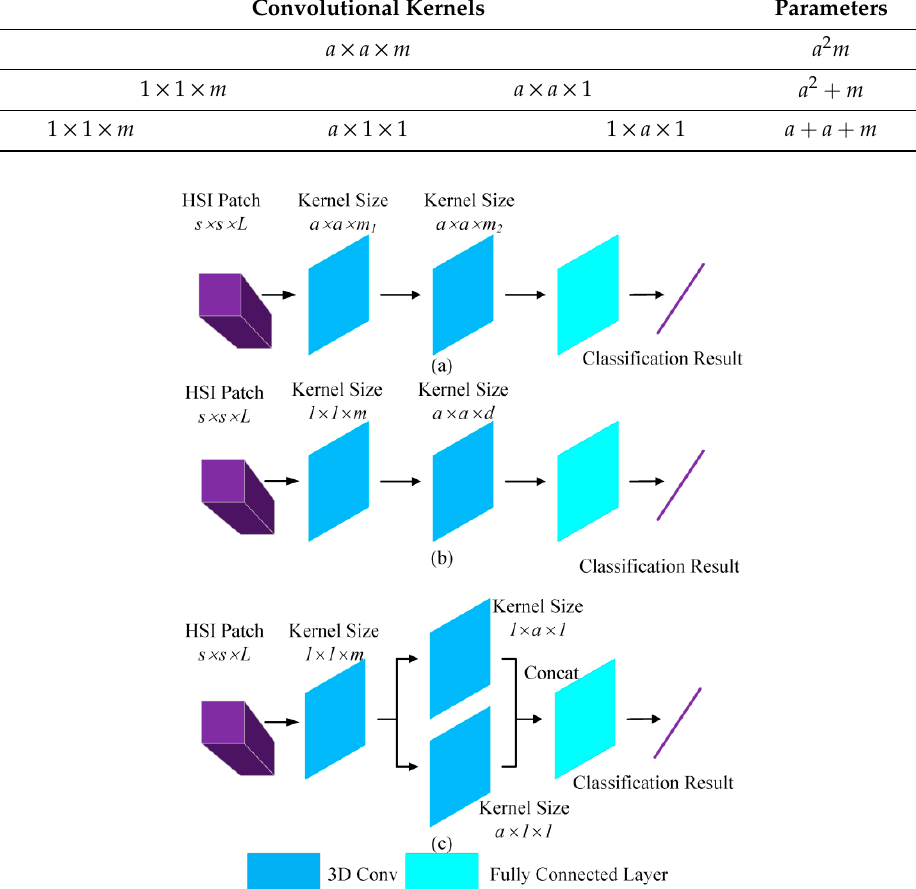
Figure 2. The structure of convolutional kernels in the 3D CNN-based method without a specific architecture. ( a ) 3D-CNN; ( b ) SSRN; ( c ) The proposed method. “Concat” refers to the concatenate operation.